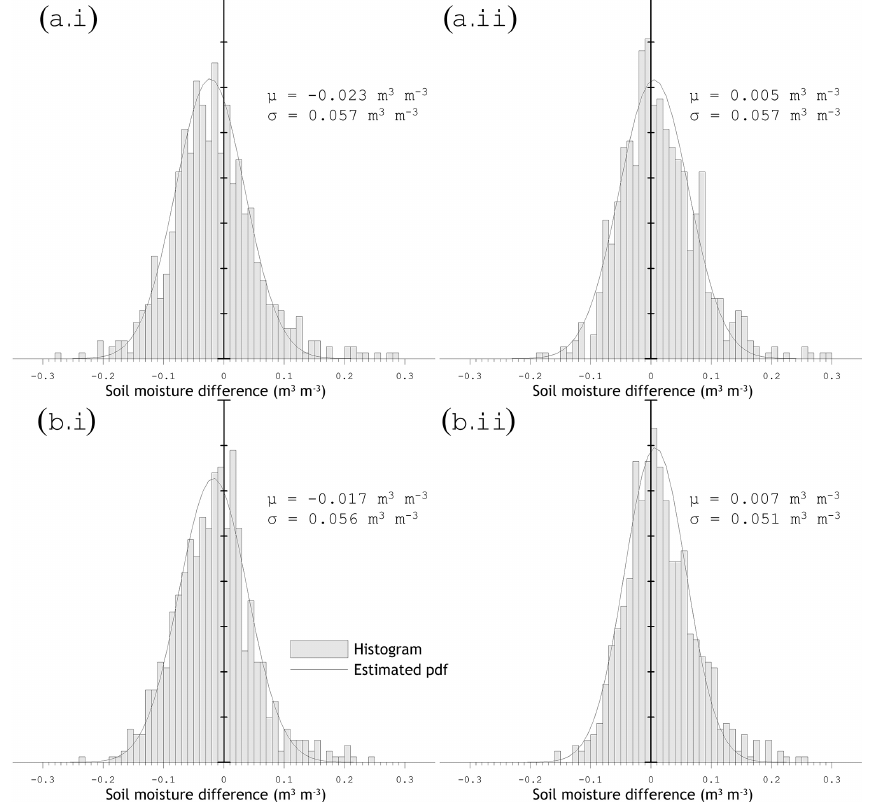
Figure 13. Histograms constructed from the differences between the SMAP SCA-V retrievals for reference pixel 4371 versus in situ refer- ences, and probability distribution functions (pdfs) obtained by fitting the mean ( µ ) and standard deviation ( σ ); panel (a) uses the data from SMAP morning overpasses and panel (b) the SMAP afternoon overpasses; (i) includes the unbiased seven-station mean as a reference, and (ii) includes the all-station mean as a